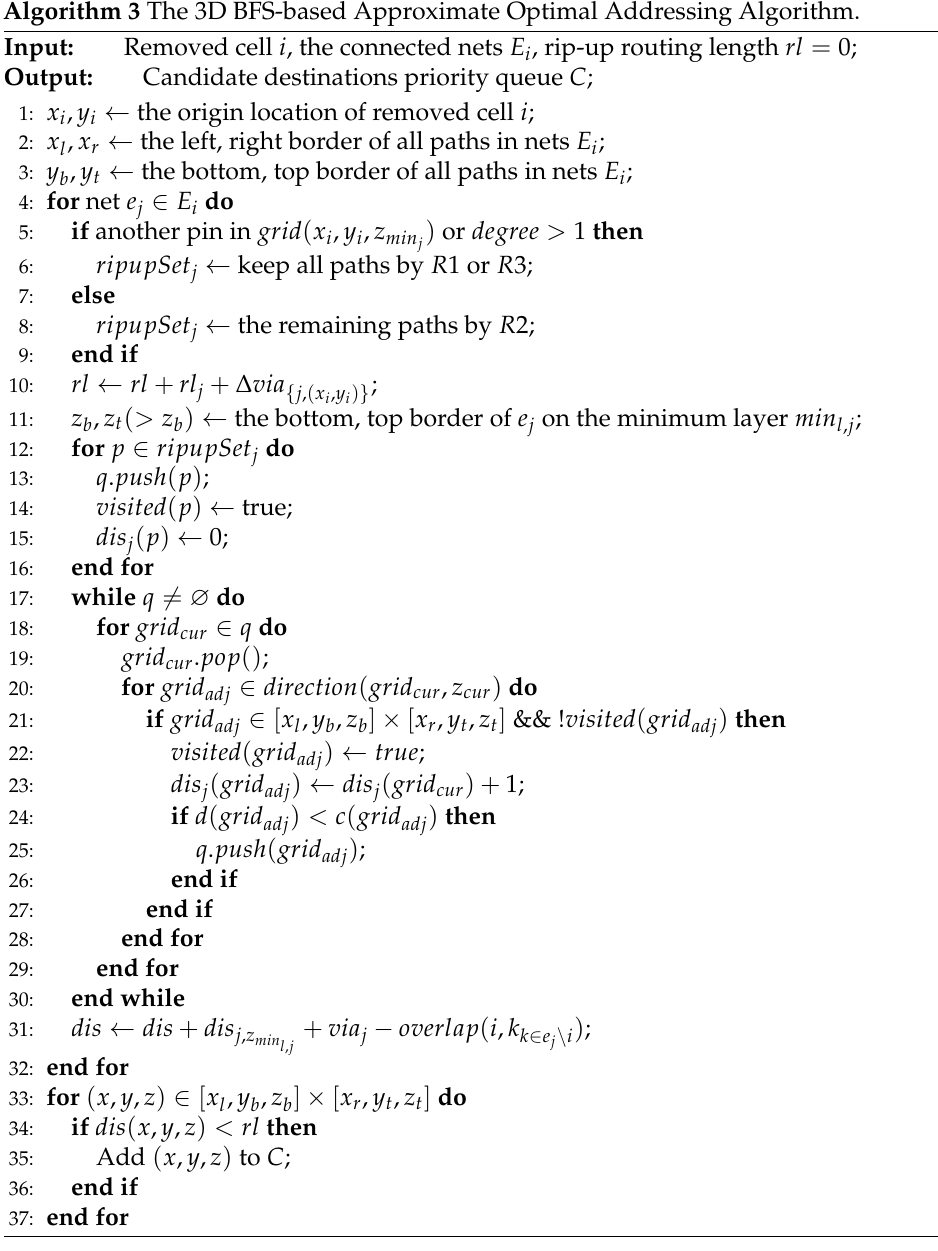
Algorithm 3 The 3D BFS-based Approximate Optimal Addressing